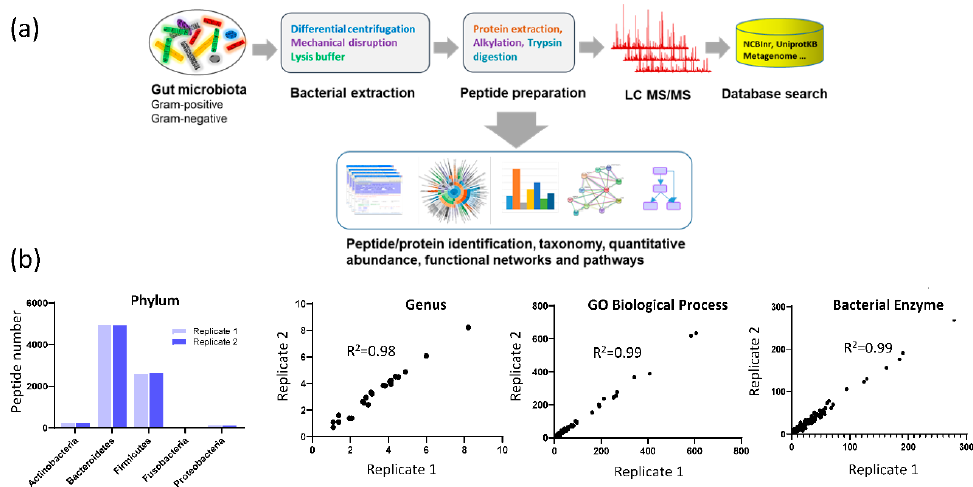
Figure 1. Study design and assay reproducibility. ( a ) metaproteomics approach; ( b ) reproducibility analysis based on replicate samples. Left panel showed the peptide number identified at the five major phyla. The right three panels were the correlation analyses of the replicates using the peptide numbers identified in Taxa, GO biological process, and bacterial enzymes, respectively.